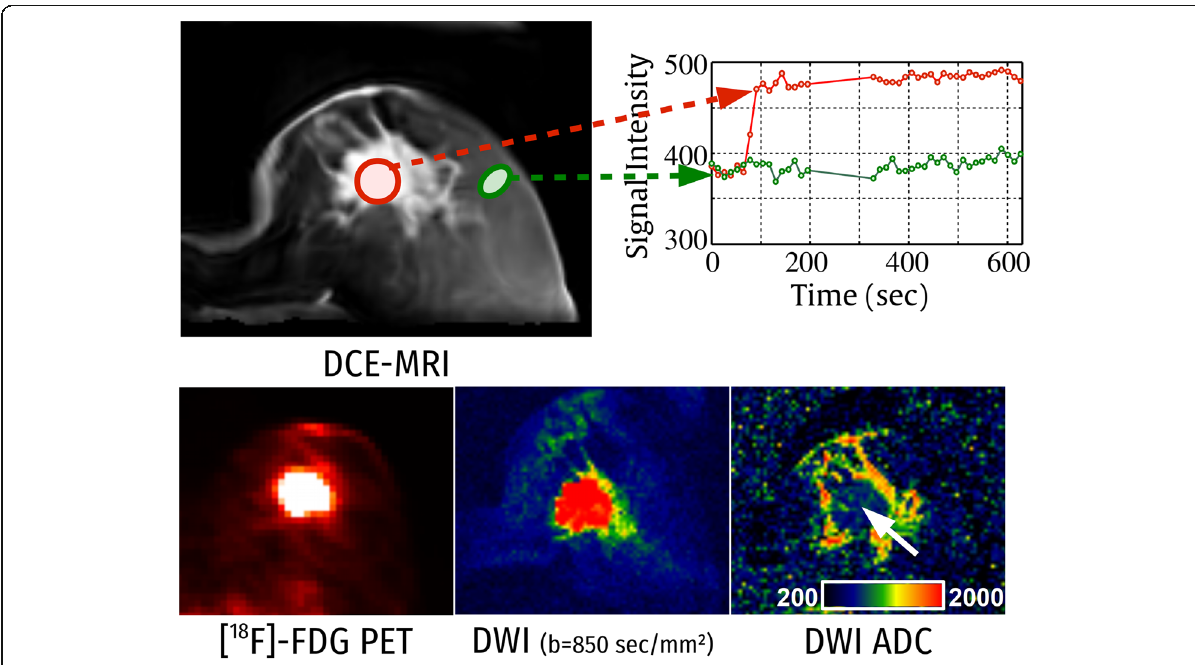
Fig. 1 Image modalities covering the lesion. Top: DCE-MRI time-signal intensity curve extracted from an ROI within the lesion (red) and from normal tissue (green), illustrating the contrast enhancement within the lesion. Bottom from left to right: 18 F-FDG-PET, DWI, and ADC map. Note the decreased ADC values in the lesion area (white